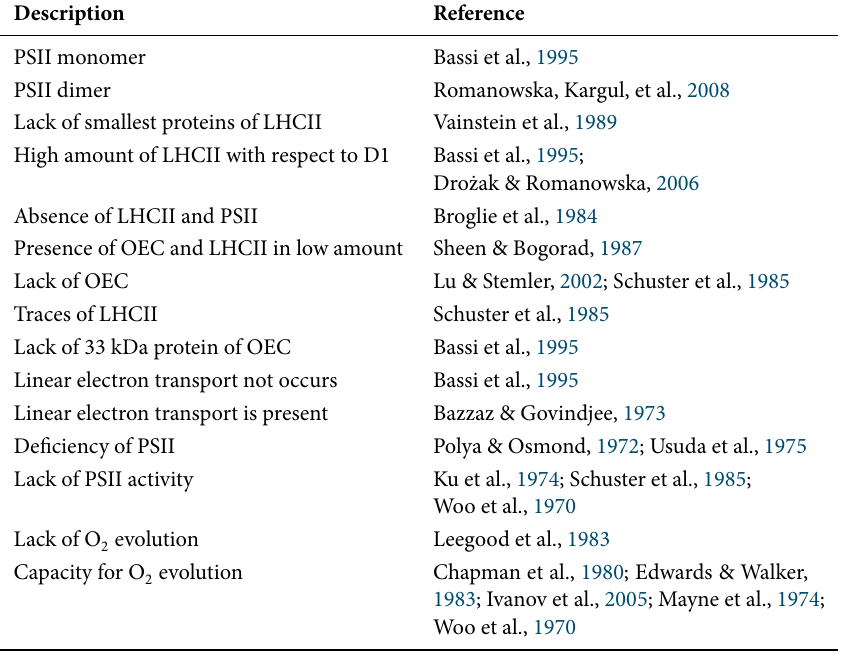
Table 1 Summary of the properties of PSII in BS chloroplasts in